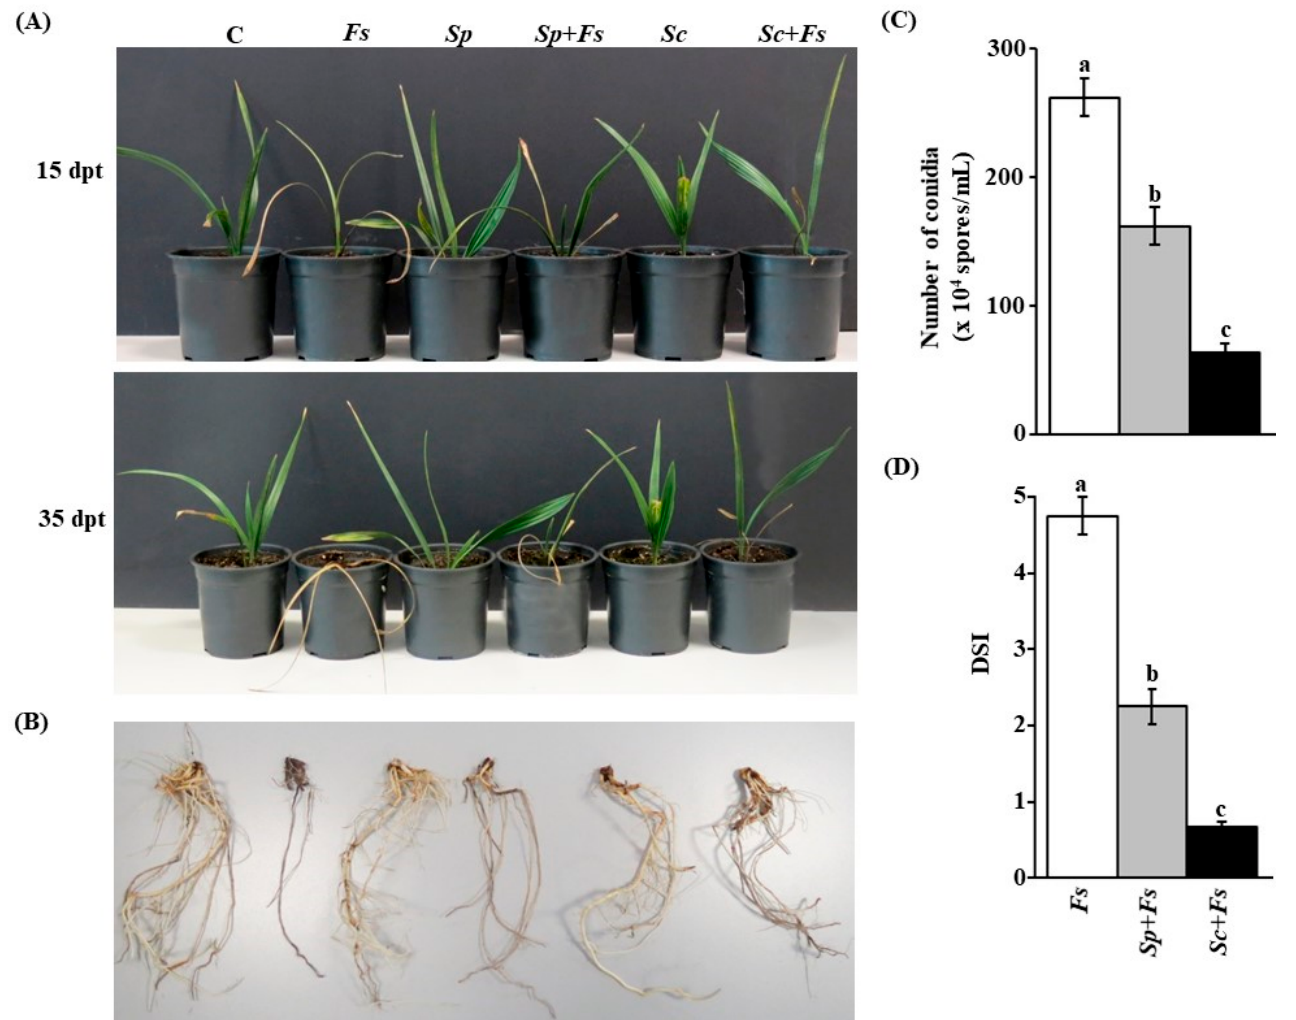
Figure 6. Preventive application of BCAs on Fusarium solani -inoculated date palm seedlings in the greenhouse. ( A ) Suppression of Fusarium wilt disease on date palm seedlings cv. Barhi using BCA1 Streptomyces polychromogenes UAE2 (isolate #16) and BCA2 Streptomyces coeruleoprunus UAE1 (isolate #28) at 15 (top) and 35 (bottom) dpt; ( B ) and recovery of root tissues infected with F. solani and previously inoculated with BCA at 35 dpt. ( C ) Number of conidia (×10 4 spores/mL); and ( D ) disease severity index (DSI) after recovery of the pathogen from affected date palm root tissues ( n = 16) treated with BCAs at 35 dpt. In ( A – D ), seedlings inoculated with F. solani at 5 days after BCA treatments. In ( C , D ), values (means ± SE of 16 replicates from two independent experiments) with different letters are significantly different from each other at p = 0.05. In ( D ), DSI was based on a scale of 5:0 = no infection, 1 = 1–10%, 2 = 11–25%, 3 = 26–50%, 4 = 51–75% and 5 = 76–100% damage including necrosis, white area in leaves or rotting in roots. Isolates #16 and #28 represent Streptomyces polychromo- genes UAE2 (BCA1) and Streptomyces coeruleoprunus UAE1 (BCA2), respectively. BCA, biological control agent; C, non- inoculated seedling (control); Fs , infected seedlings with F. solani only; Sp or Sc , seedlings inoculated with only S. polychro- mogenes UAE2 or S. coeruleoprunus UAE1, respectively; Sp + Fs or Sc + Fs , seedlings inoculated with the individual BCA (either S. polychromogenes UAE2 or S. coeruleoprunus UAE1, respectively) 5 days prior to F. solani inoculation; dpt, days post treatment.